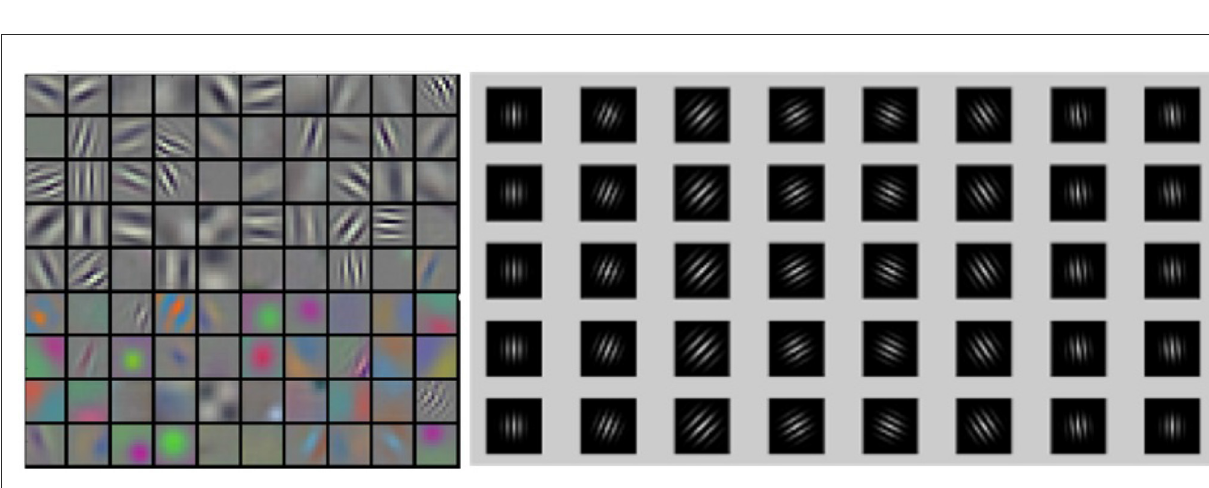
FIGURE2 Comparison between CNN filters and Gabor filters. Latent features illustration of CNN filters (left) and Gabor filters (right) .